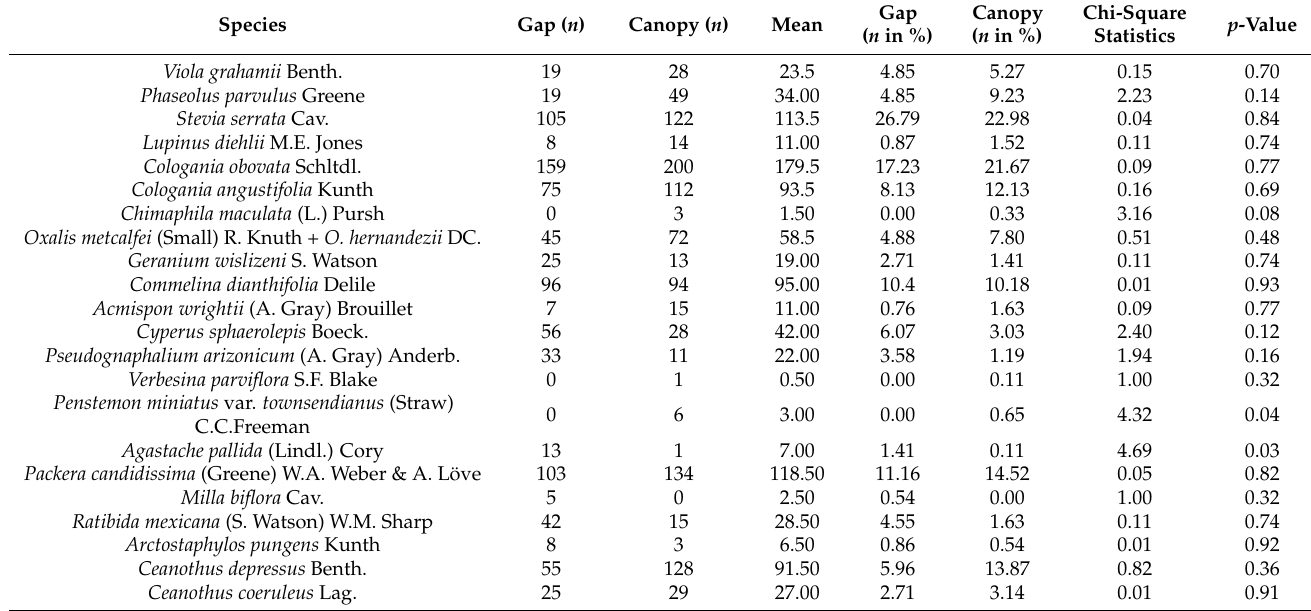
Table 2. Occurrence of species in gaps and under the